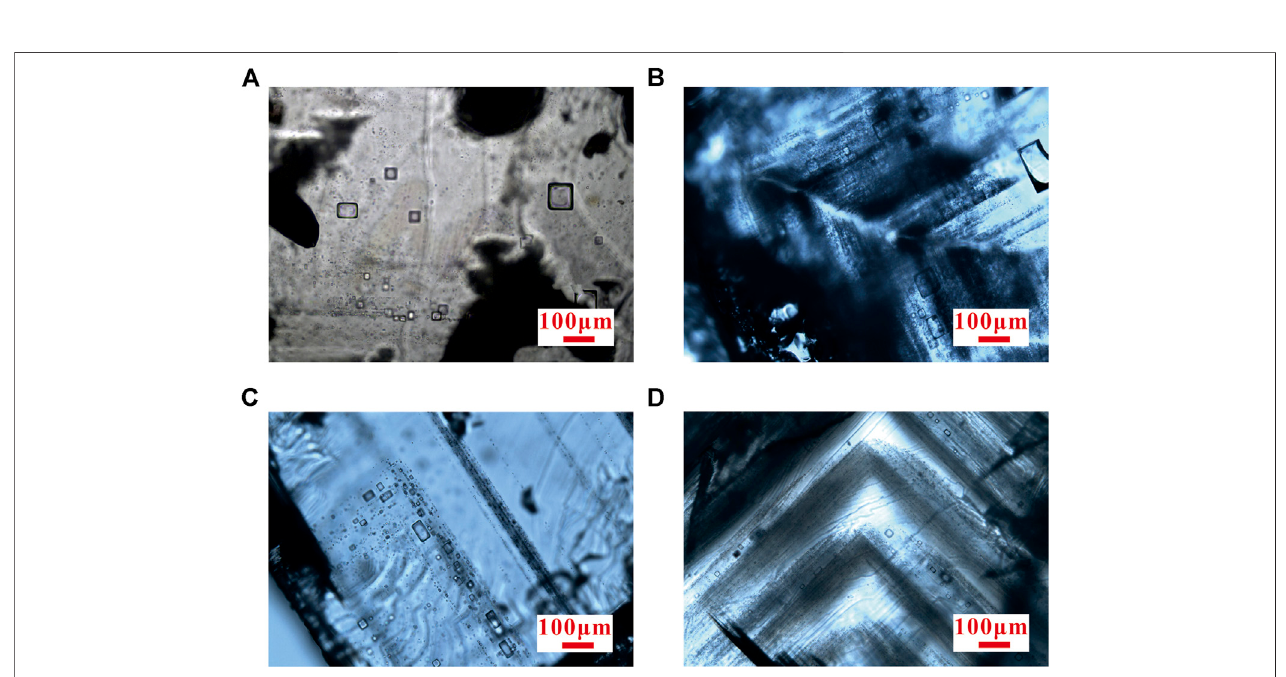
FIGURE4 | Petrologic characteristics ofhalite fl uid inclusions. (A) Irregular dispersion ofprimary halite fl uid inclusions. (B,D) Parallel fl uid inclusion bandsin hopper primary crystals that form bright and dark bands with host minerals, with dark ones being fl uid inclusion groups. (C) Primary halite fl uid inclusions regularly distributed along the crystal growth.